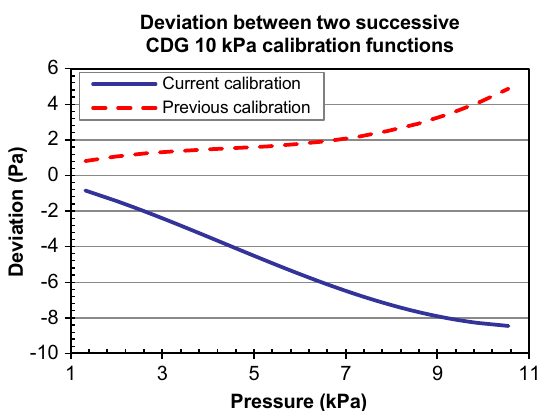
Fig. 5. Plot of the deviationof two calibration functions of a CDG 13kPa full scale, in absolute pressure mode. The two calibrations are spaced by about 12 months. The deviation is the difference between the CDG calibration function and a linear function g ( U (cid:1) U 0 )= a ( U (cid:1) U 0 ), where a is an arbitrary coef fi cient.